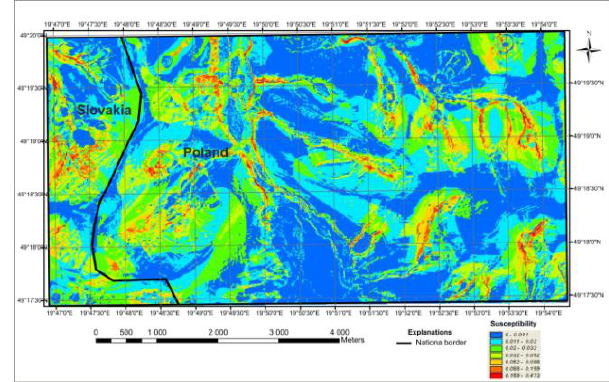
Fig.5. Landslide susceptibility map.